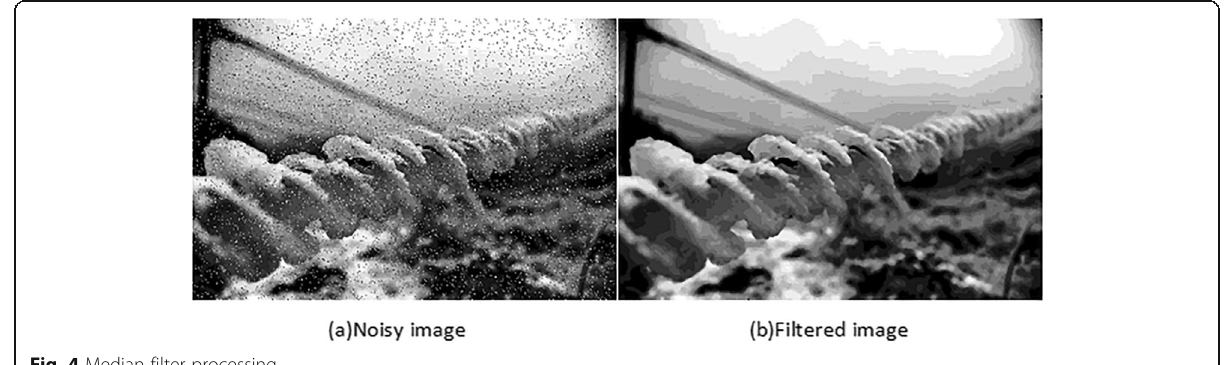
Fig. 4 Median filter processing